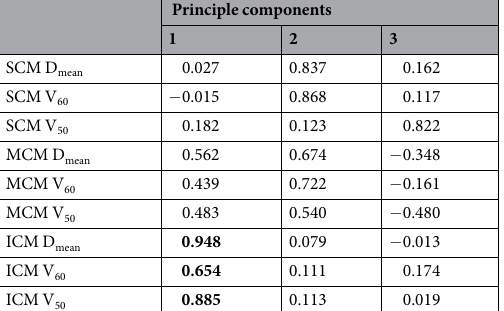
Table 6. Rotating element matrix of the principle component analysis.